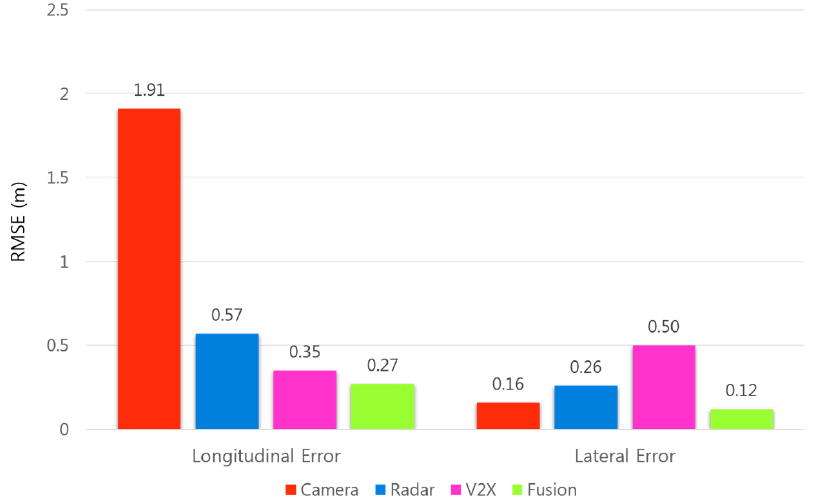
Figure 12. Relative positioning accuracy in the longitudinal and lateral directions for the combined sets of the measurements obtained from the two normal driving scenarios. Table 11. Cut-in driving scenario